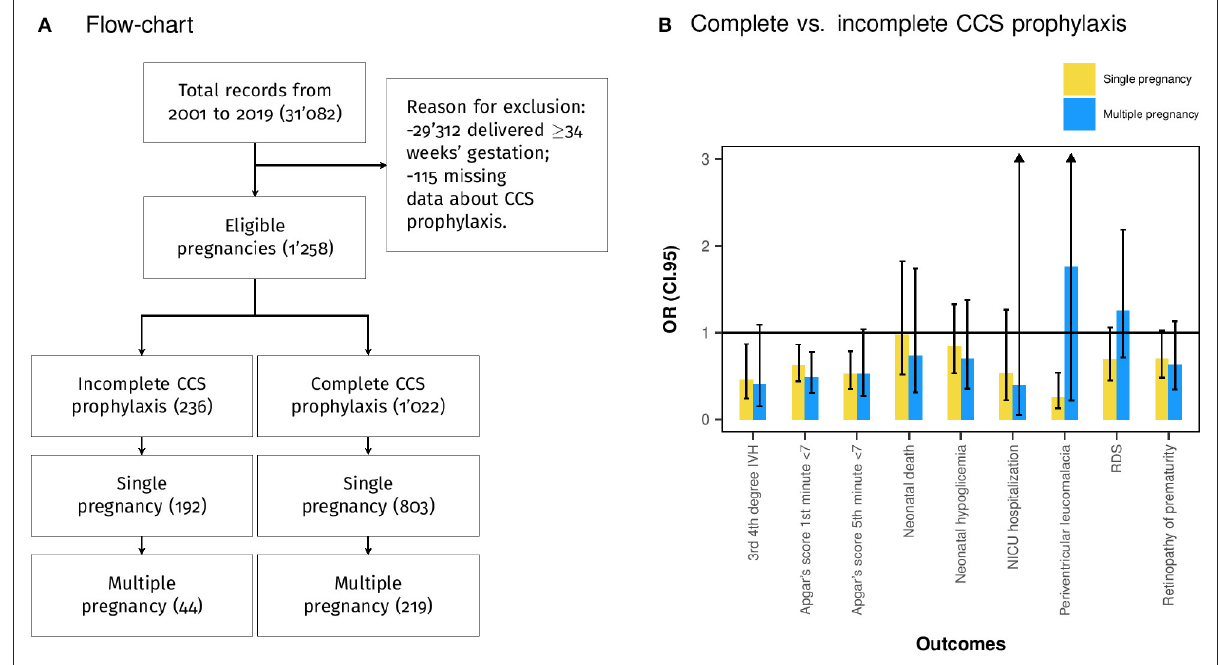
FIGURE1 (A) Population selection flowchart. (B) Bivariate logistic regression analysis considering as independent variable complete corticosteroid (CCS) prophylaxis and dependent variables the assessed outcomes. The plot shows the OR and the 95% confidence interval (CI.95) pairwise for single and multiple